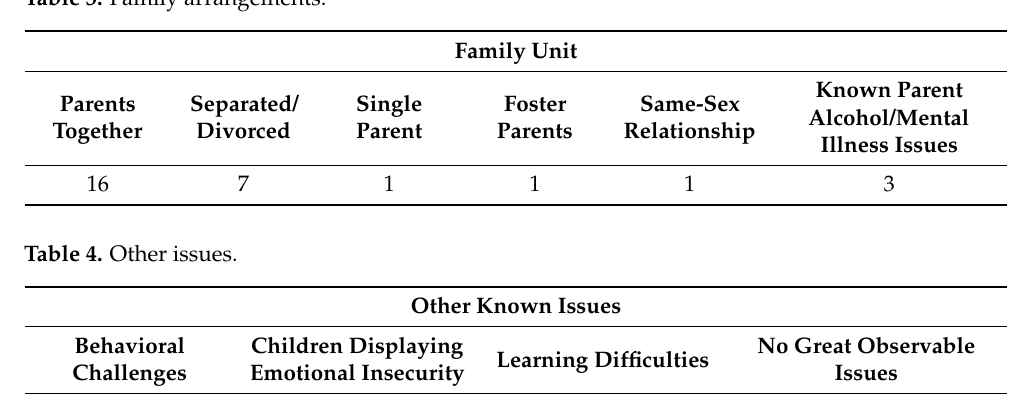
Table 3. Family arrangements.